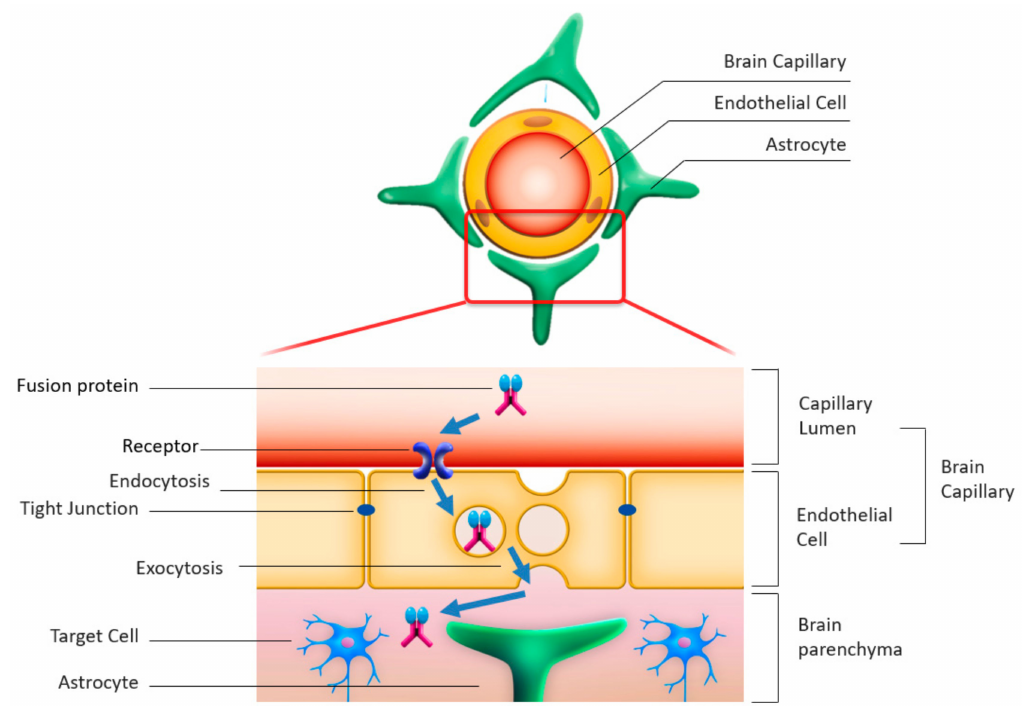
Figure 2. Schematic representation of the transcytosis mechanism.